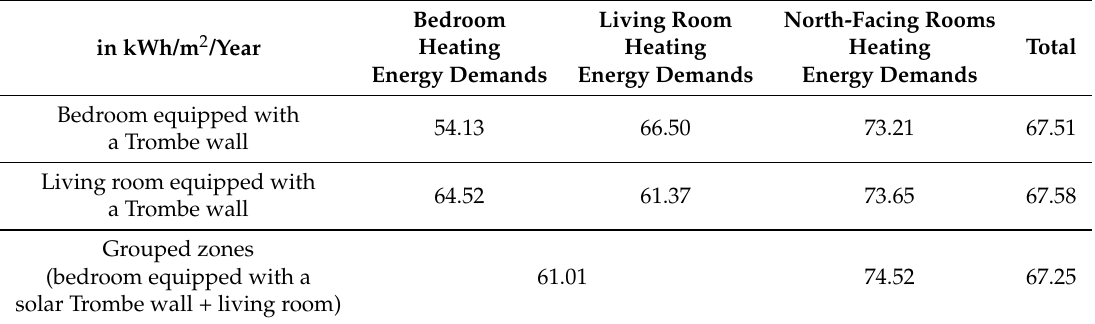
Table 11. Comparison of the heating energy demands in Paris weather conditions, for the basic case, the case of the living room fitted with a solar Trombe wall, and the case of grouped thermal